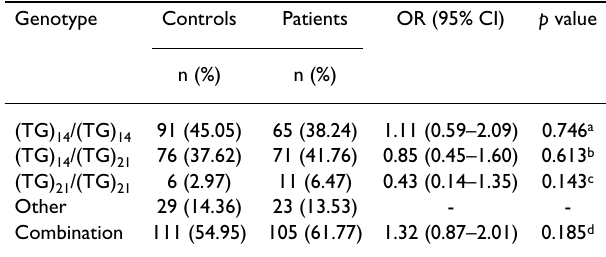
normal controls and preeclamptic patients Allele TG repeat Controls